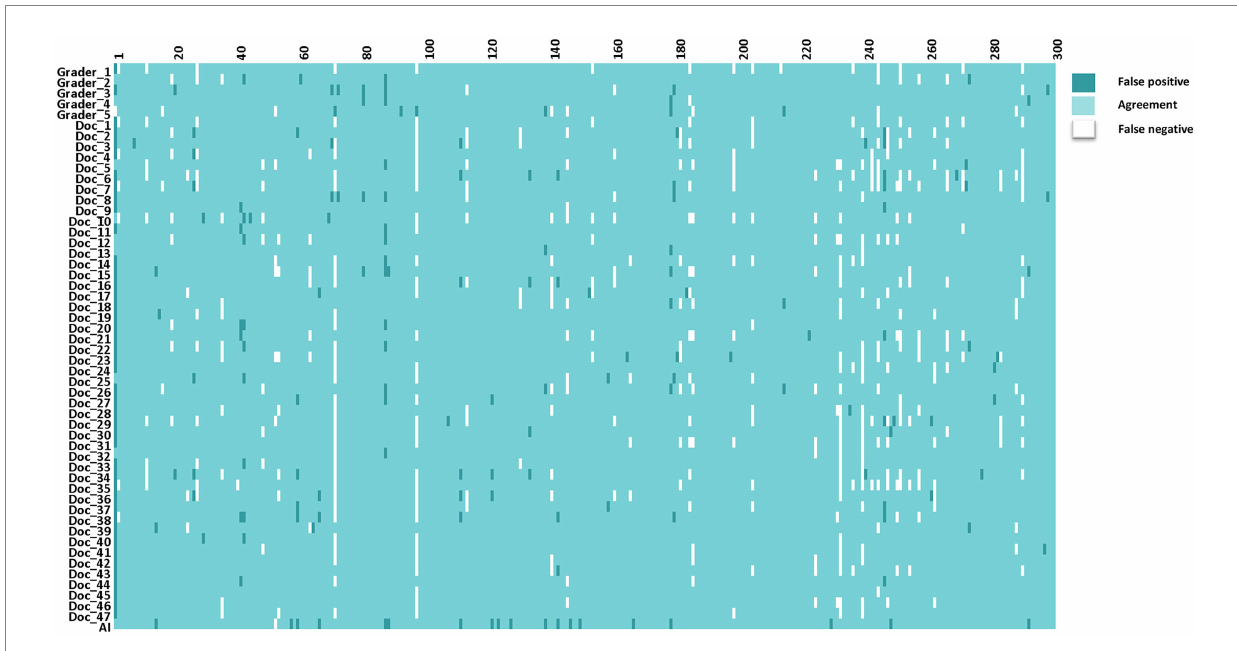
FIGURE 2 The interpretations of graders, ophthalmologists, and artificial intelligence compared with the reference standards for each of the 300 fundus photographs for diabetic retinopathy.